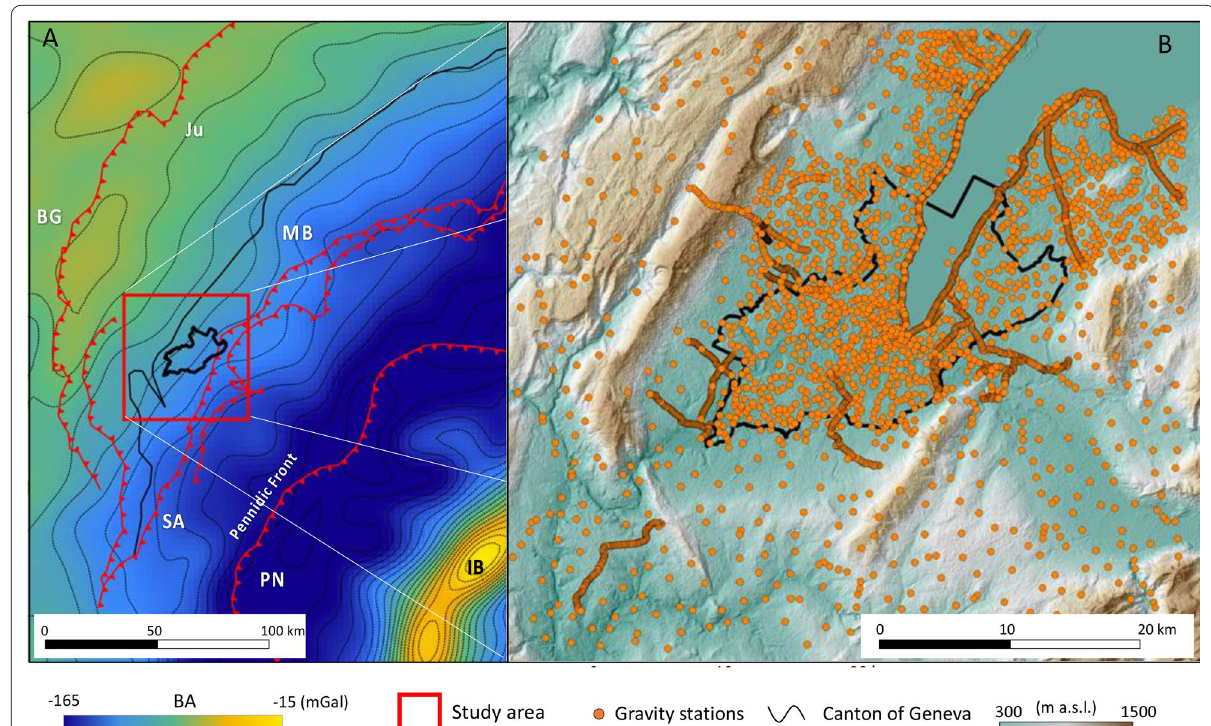
Fig. 3 A Bouguer Anomaly over Western Alps and surrounding regions ( modified from WGM2012 GLOBAL MODEL—Balmino et al., 2012); B Gravity stations in the study area. BG: Bresse Graben; Ju: Jura; MB: Molasse Basin; SA: Subalpine Domain; PN: Pennidic Nappe; IB: Ivrea